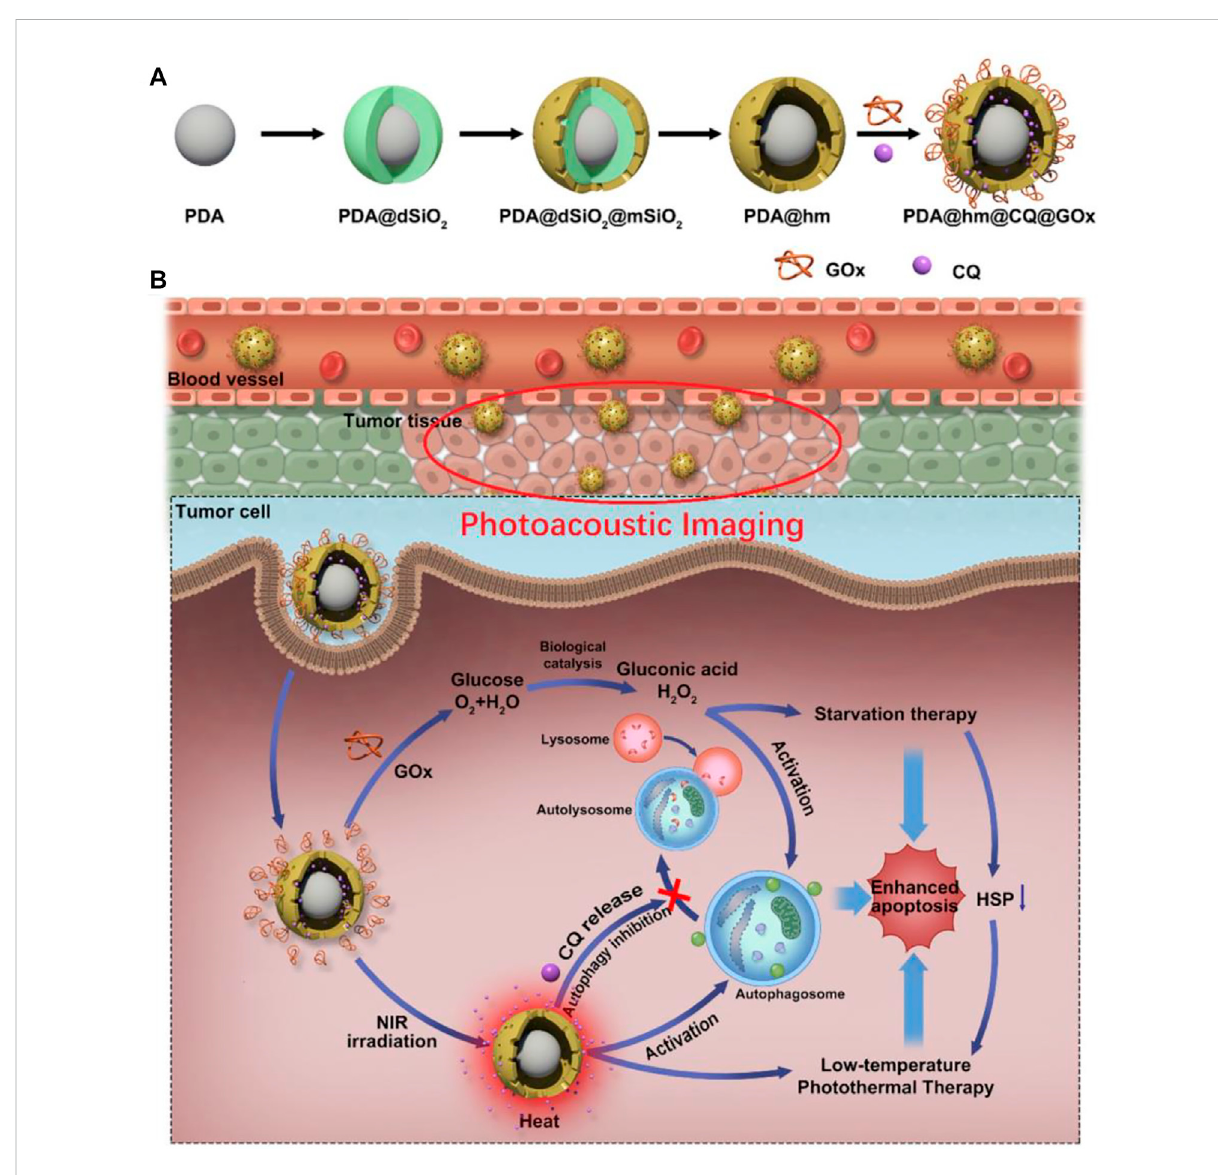
FIGURE 3 Schematic diagram of (A) the construction of PDA@Hm@CQ@GOx and (B) the enhancement of low-temperature PTT through inhibition of autophagy and energy metabolism (Shao et al.,